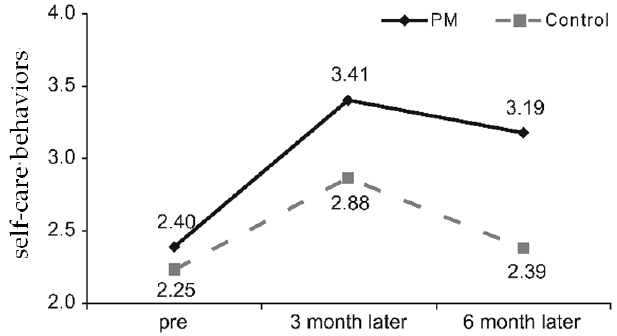
Figure 2. Differences in s elf-care behavior according to education groups. PM, pattern management. Figure 2. Di ff erences in self-care behavior according to education groups. PM, pattern management.